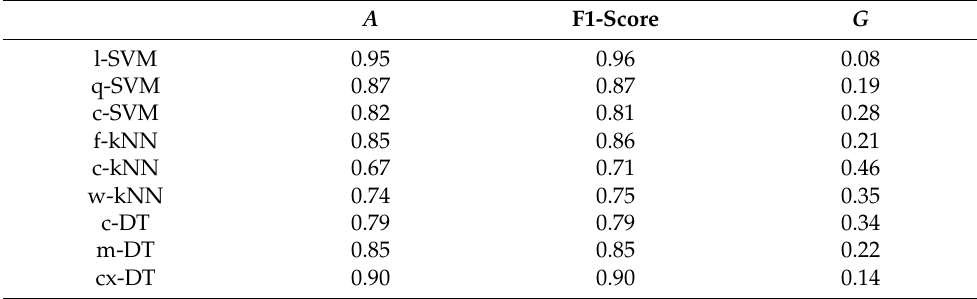
Table 5. Accuracy ( A ), F1-score and goodness index ( G ) achieved by the nine tested